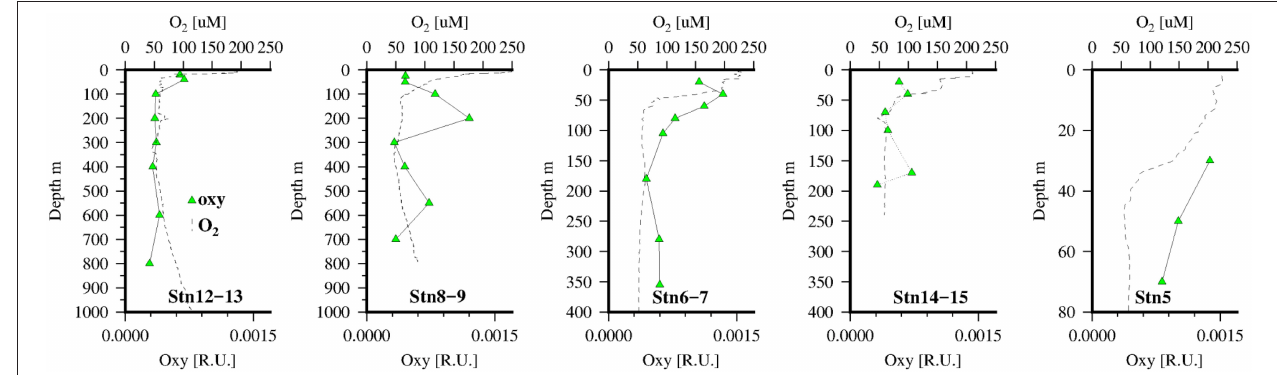
FIGURE 8 | Dissolved O 2 (dotted line) and FDOM ( λ ex/ λ em = 420/640) pigment “oxy” (green triangles) at 5 stations along the transect in the Mauritanian Upwelling.